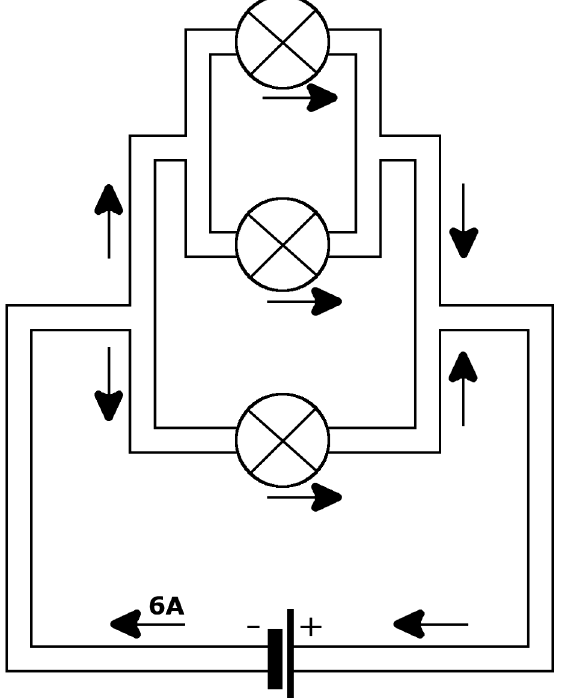
FIG. 11. A sample task to help students determine the electric current in a parallel circuit of three light bulbs based on an analysis of electric pressure differences. The objective of the task is to engage agency in students ’ thinking while decreasing the activation priority of the guiding p-prim. The arrows refer to the direction of electron